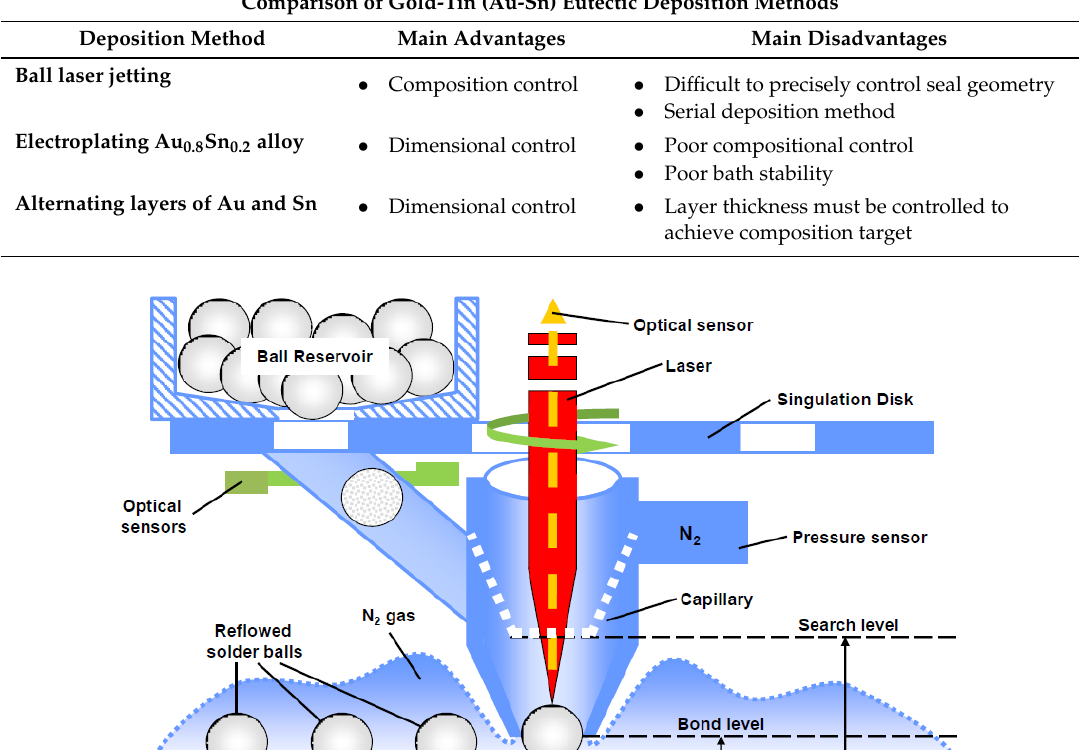
Table 4. Comparison of various Au 0.8 Sn 0.2 deposition methods.